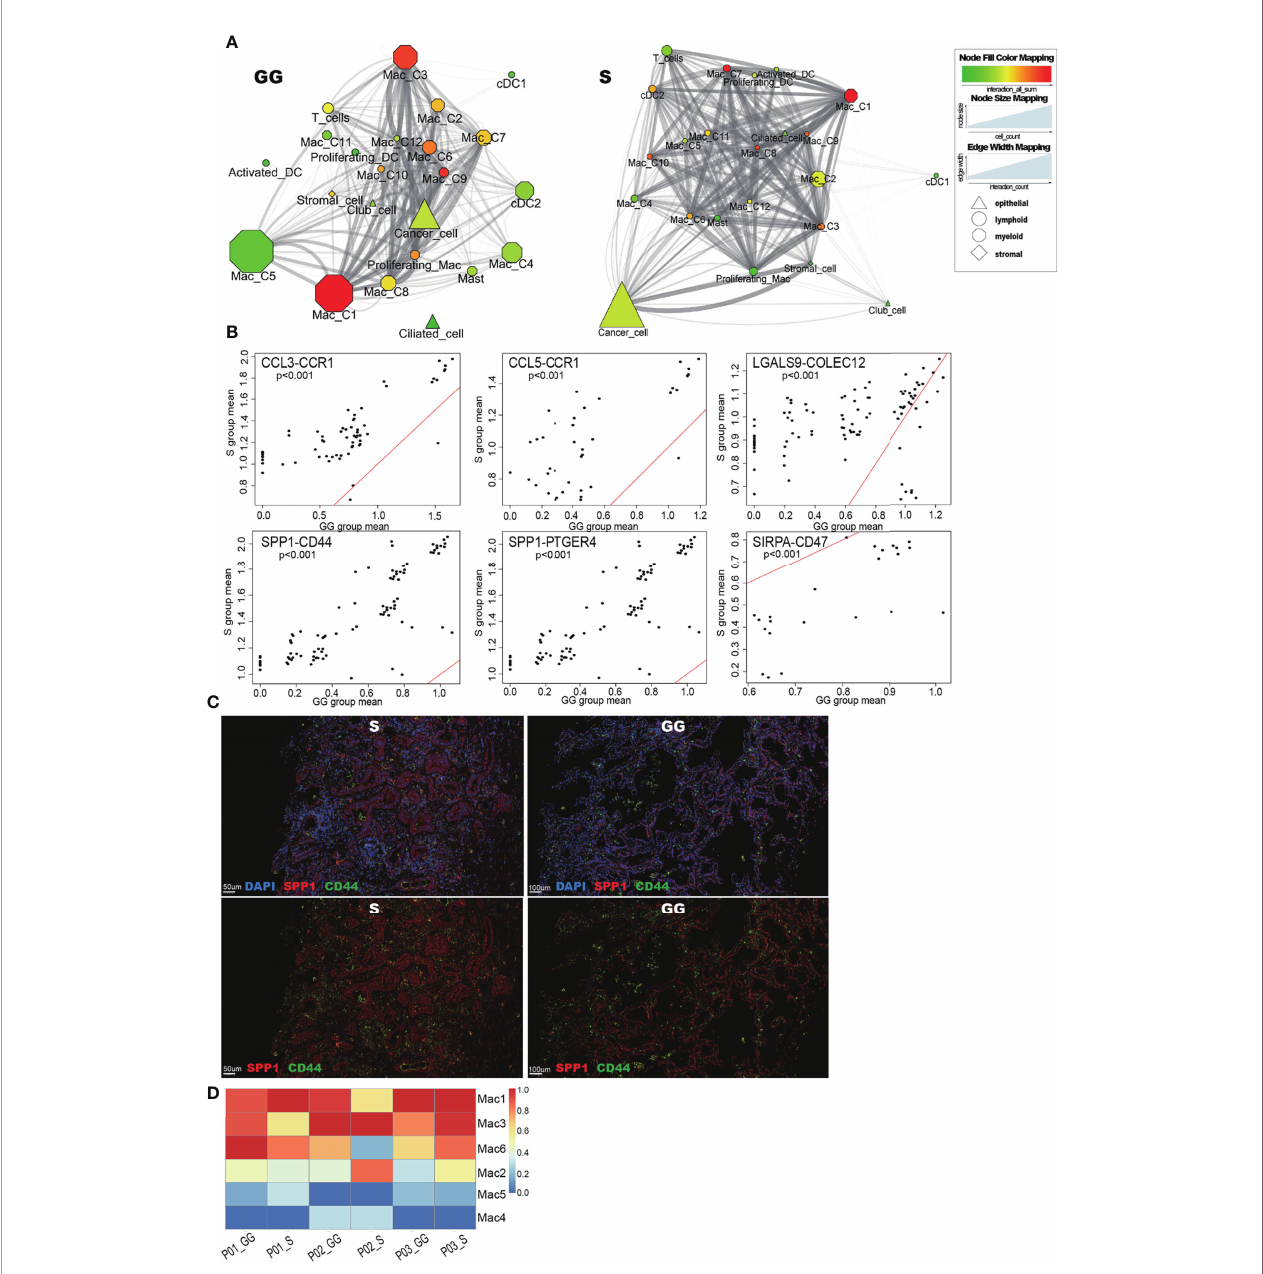
FIGURE 8 | (A) The Cytoscape reveals different cell – cell interaction models between GG component (left) and S component (right). Organic layout based on a force- directed layout paradigm was used. Edges connect cell subsets (nodes) with signi fi cantly correlated ligand – receptor pairs (p < 0.05). Only high con fi dence of connection between a pair of cell subsets is visible (ligand – receptor pairs >60). Nodes were annotated by lineage (shape), cell numbers (size), and total interaction pairs (color). Edges ’ width and transparency were annotated with the account of ligand – receptor pairs. (B) The scatter plot shows the GG- and S-speci fi c macrophage-related interaction pairs. Each dot shows a pair of cell subsets interacting with the ligands and receptors, and each pair consists of at least one macrophage subset. The x-axis shows the mean expression value of ligand – receptor genes in the cell subsets in the GG component, and the y-axis shows the mean expression value of ligand – receptor genes in the cell subsets in the S component. Each cell pair satis fi es the universal expression among samples. If dots are enriched above the red line (y = x), we de fi ned the interaction pairs as S-speci fi c. If they are enriched below it, we de fi ned them as GG-speci fi c interaction pairs. Wilcoxon rank-sum test was used for analysis. (C) IFA shows simultaneous upregulation of SPP1 (red) and CD44 (green) in S components (scale bar, 50 m m) in comparison with the GG components (scale bar, 100 m m). (D) The heatmap shows the total interaction of macrophage subsets (Mac1, 2, 3, 4, 5, and 6, y-axis) within each sample